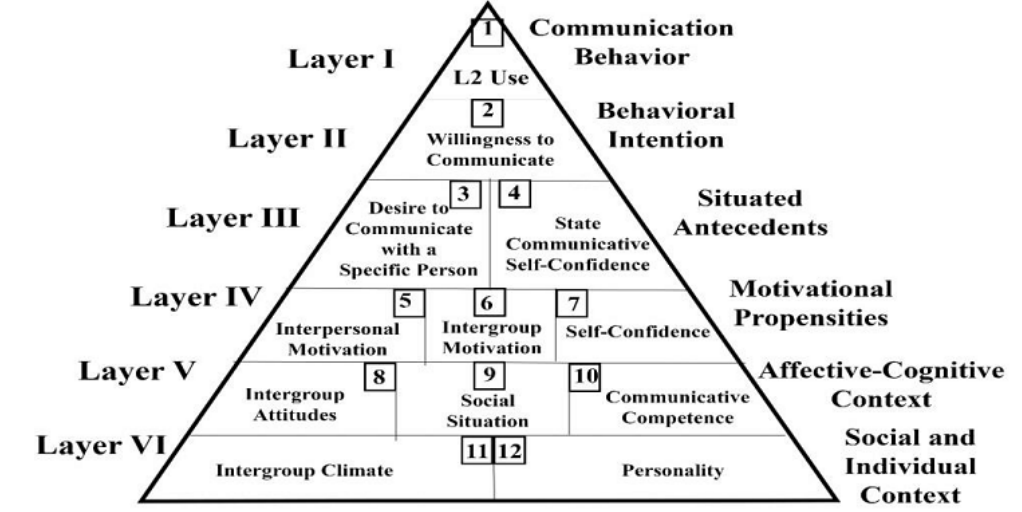
Figure 1. Heuristic model of L2 WTC (MacIntyre et al., 1998